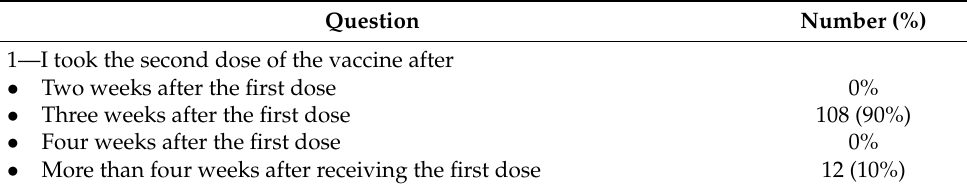
Table 3. Symptoms and practices following the second dose of the Sinopharm